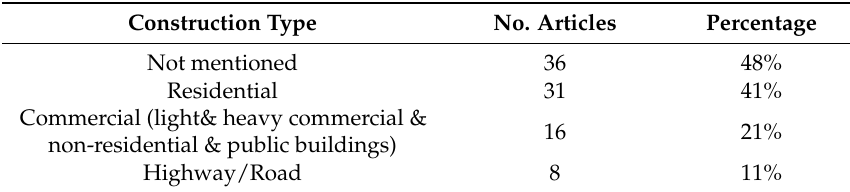
Table 5. FFH studies within different construction